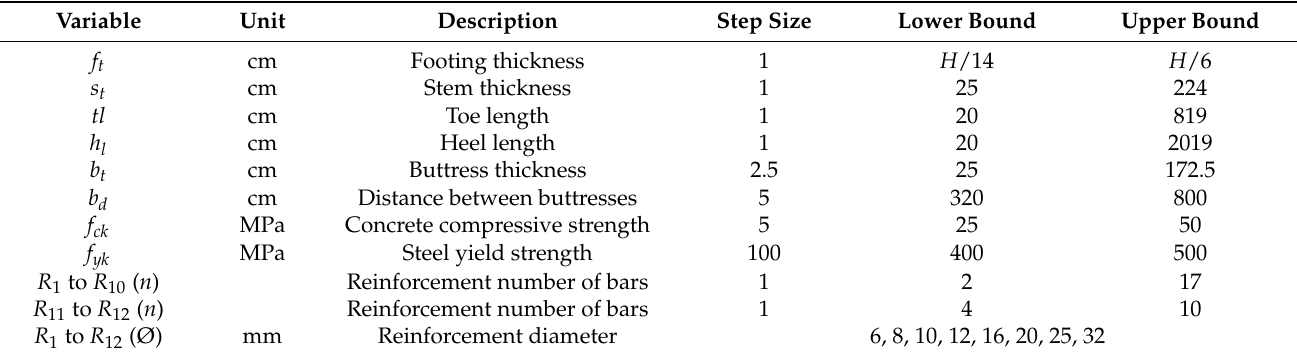
Table 2. Discrete design variables description.